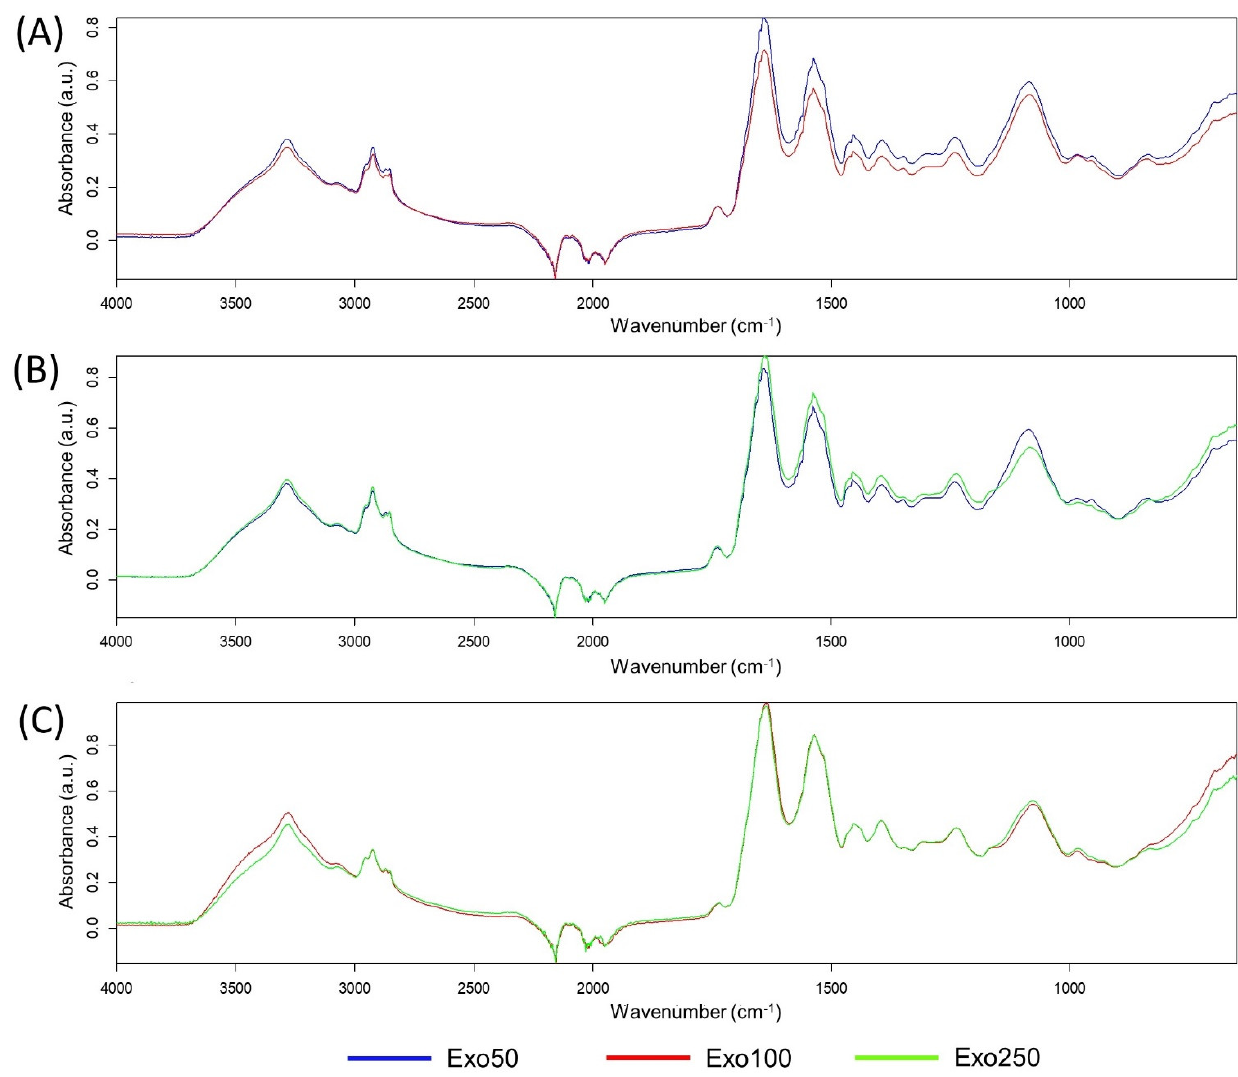
Figure 8. FTIR Quick Compare results using a whole range of FTIR spectra from 4000 to 650 cm − 1 . Comparison of Exo50 (blue line) vs. Exo100 (red line) ( A ). Comparison of Exo50 (blue line) vs. Exo250 (green line) ( B ). Comparison of Exo100 (red line) vs. Exo250 (green line) ( C ). Raw spectra in the range of 4000–650 cm −1 were used for the Quick Compare analysis.